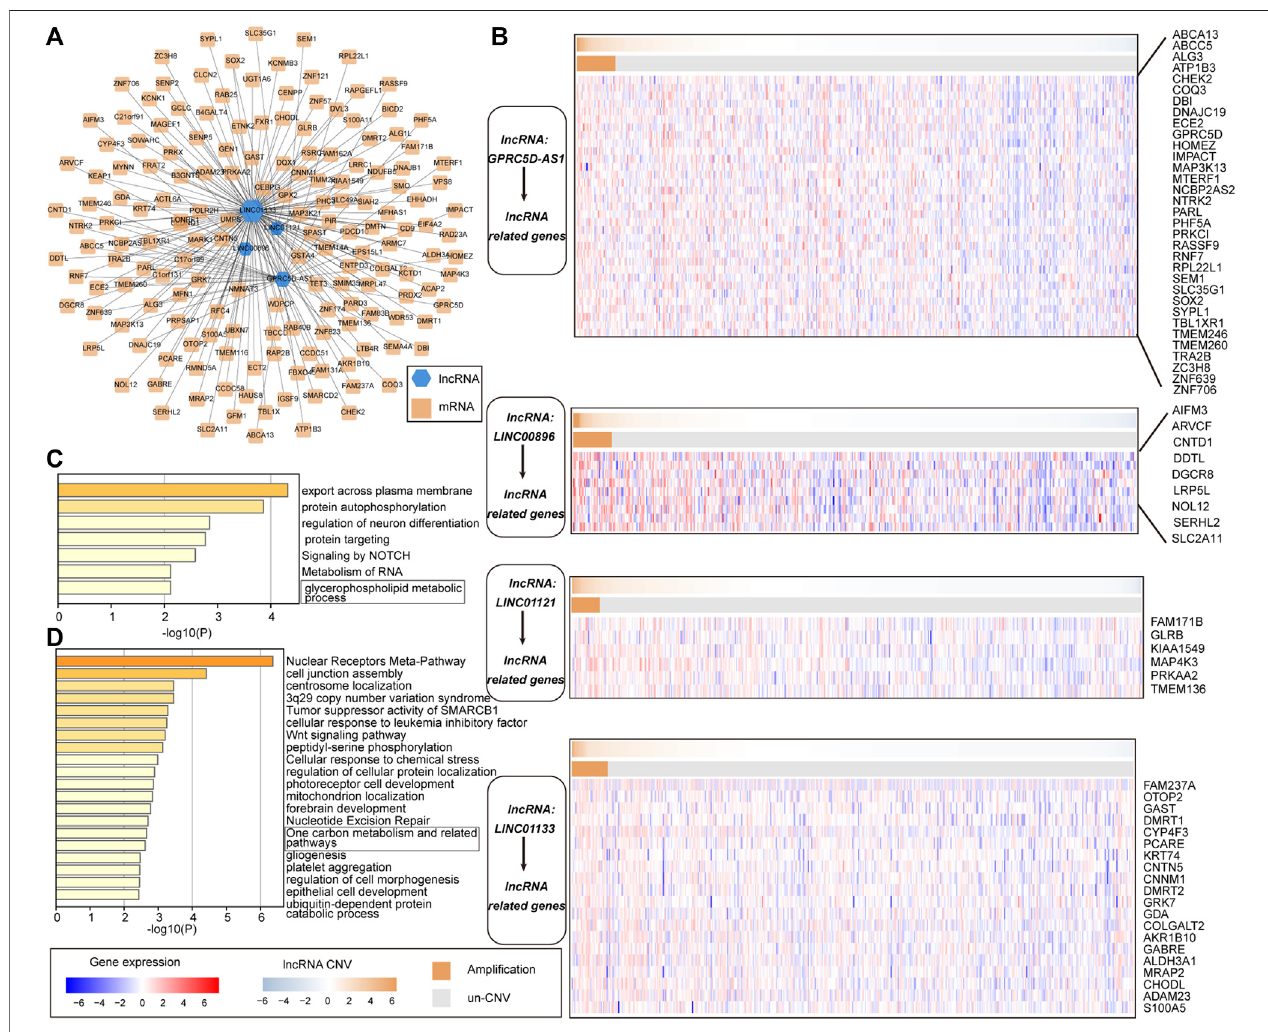
FIGURE 6 | The cascade response of pr-lncRNA-CNV-mRNA carcinogenic mechanism. (A) pr-lncRNA-mRNA regulatory network showing the dysregulation of functional genes driven by lncRNA-CNV. The green hexagon represents lncRNA, and the yellow square represents mRNA. (B) Four (lncRNA-CNV) gene cascade responses.TheheatmapcombinationincludesthecopynumberandtheexpressionoflncRNA-relatedgenesforthefourpr-lncRNAs.The fi rstrowofeachcombination represents the copy number amplitude of lncRNA, and the second row represents the copy number ampli fi cation and deletion of lncRNA. (C – D) The enrichment results for genes related to lncRNA GPRC5D-AS1 and LINC01133 are displayed by bar graphs, colored by p